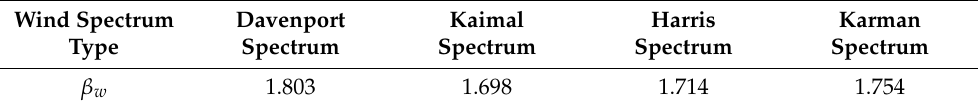
Table 2. Comparison of weighted wind-induced vibration coefficients among different wind spectra type.